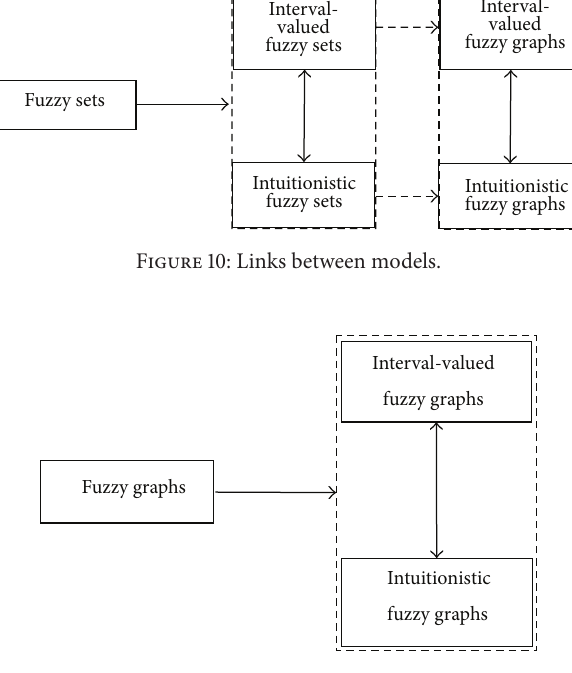
Figure 11: Link between IFGs and